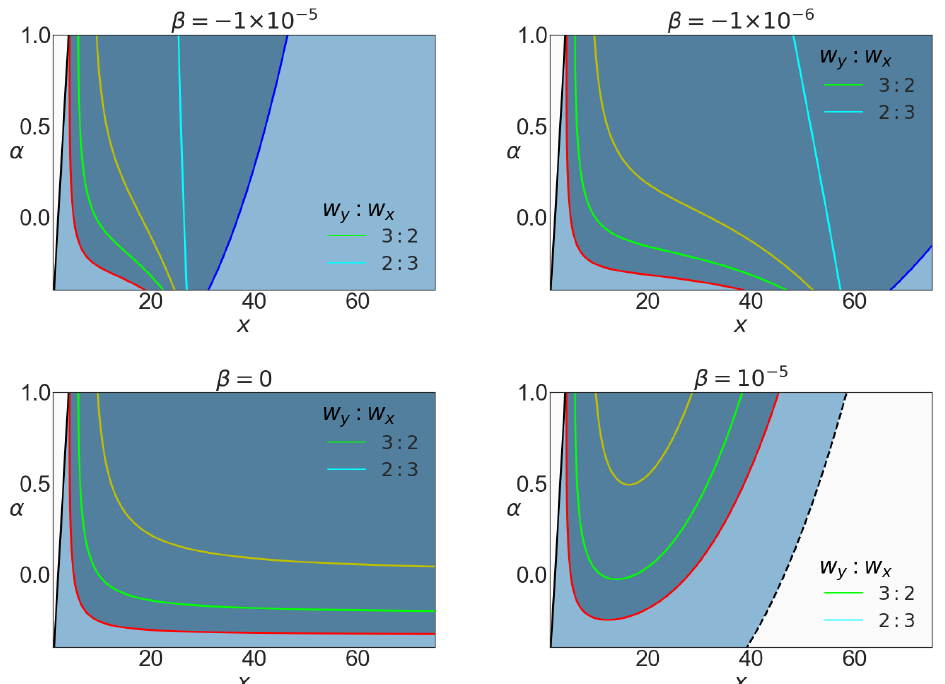
Figure 8. The light blue area depicts the region of existence of the circular orbits. This region is bounded by the thick black curve ( 2 S − x = 0 ) and the dashed line ( S = 0 ) . The blue-gray region shows the stability of the orbit with respect to vertical and radial perturbations. This area is bounded by the blue curve ( w 2 y = 0) and the red curve ( w 2 x = 0). In this ( x , α ) -plane, the lime curve shows = 3 = 2 where we have w y and the light cyan curve w y . w x w x 2 3